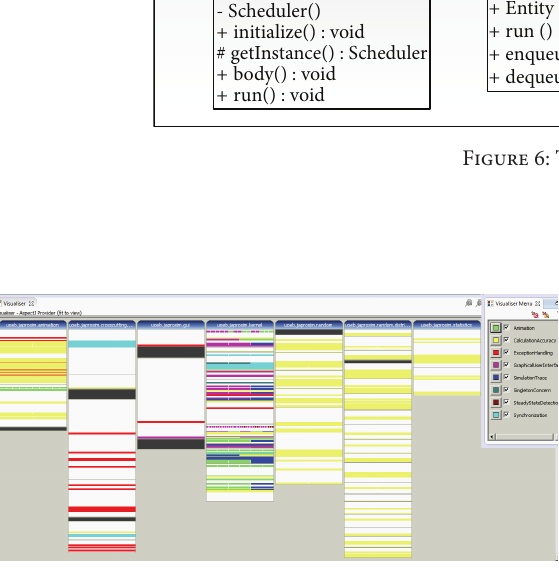
Figure 7: The interaction between aspects and AO Japrosim pack-